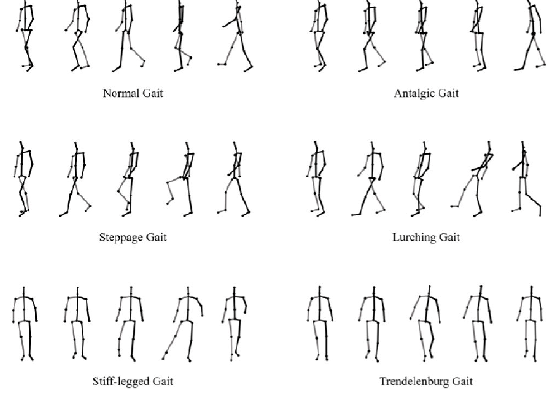
Figure 2. Skeleton data of normal and pathological gaits.